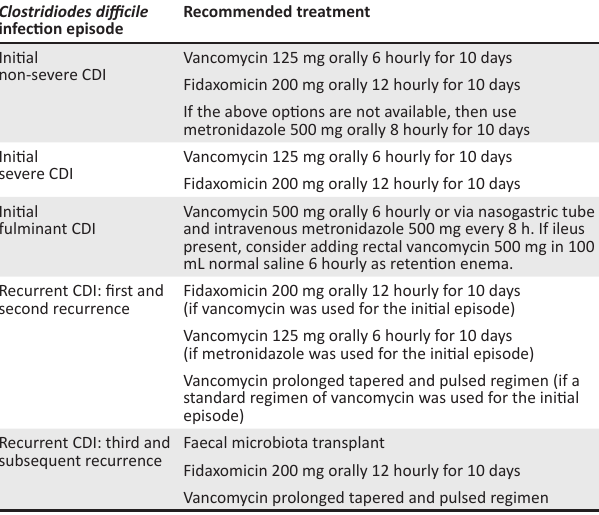
TABLE 4: Recommendations for the treatment of Clostridioides difficile infection in